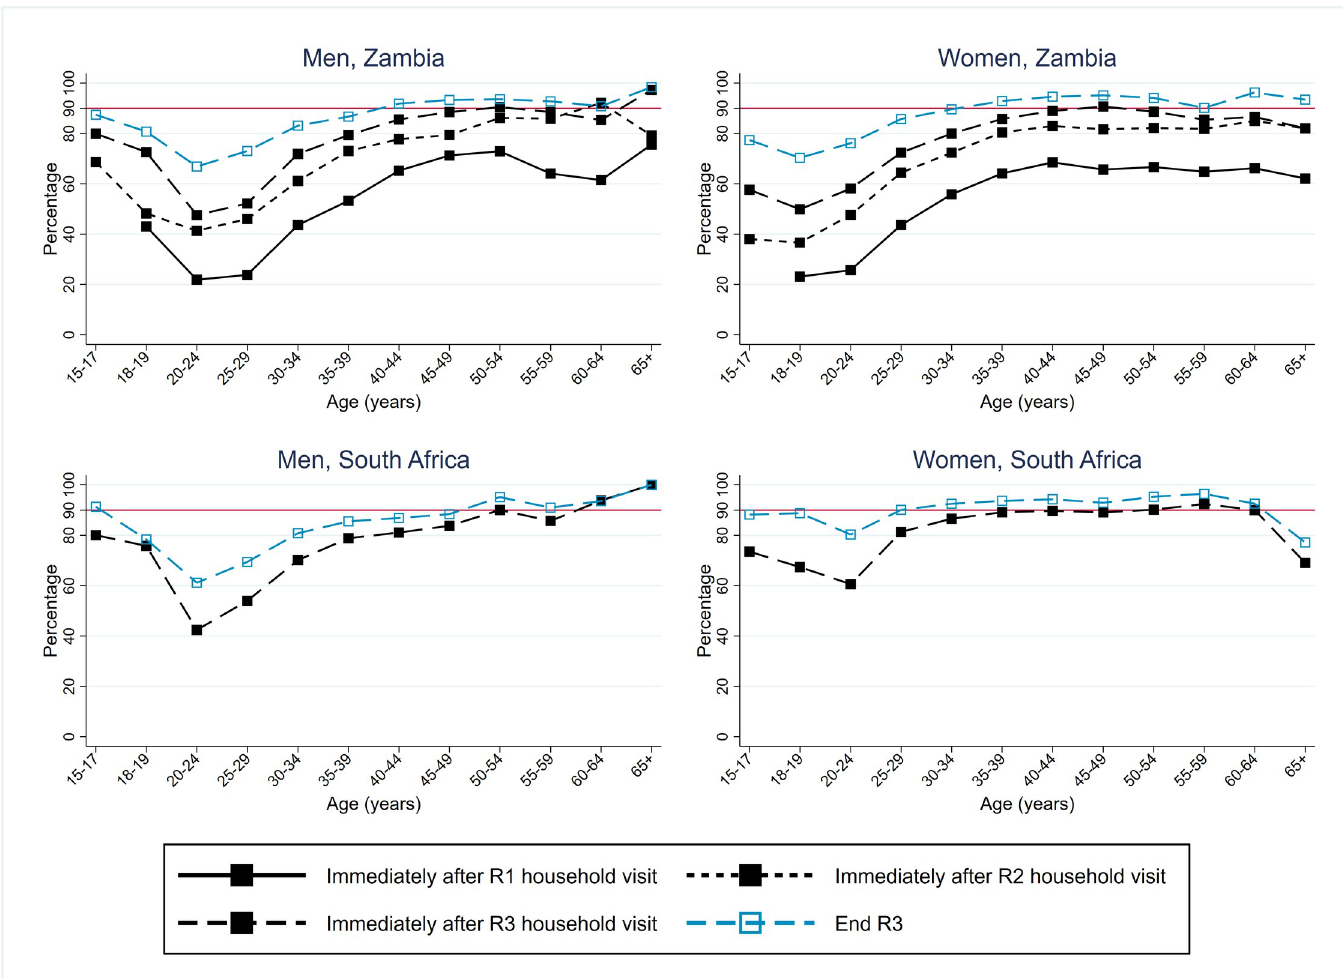
Fig 7. Arm A: Estimates of coverage against the second 90 target, Zambian communities R1–R3, and SA communities R3, by sex and age group (with extrapolation to the total population). R1, Round 1; R2, Round 2; R3, Round 3; SA, South